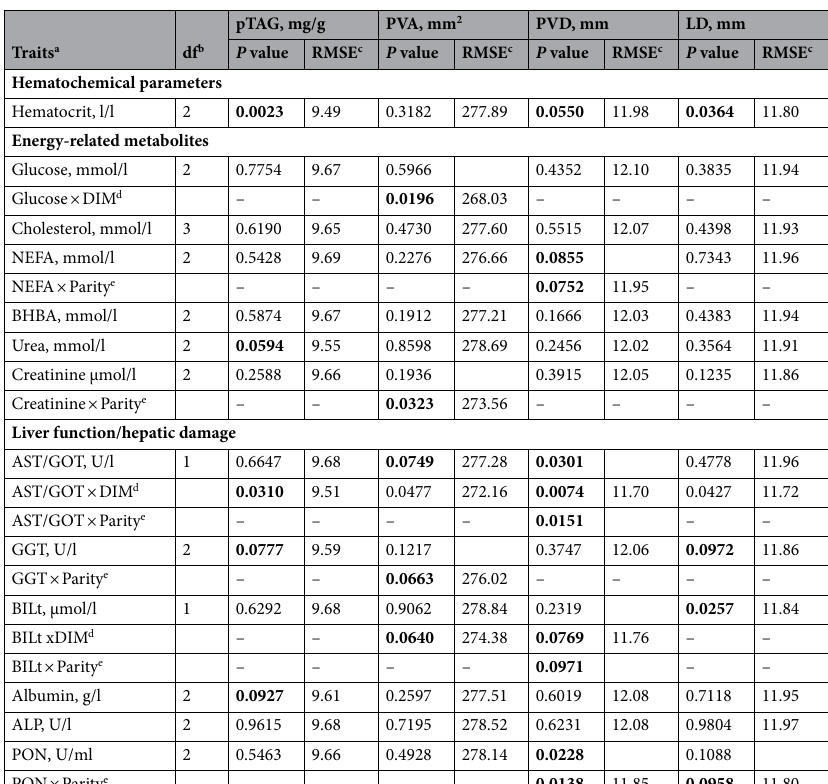
Table 2. Results from linear mixed model ( P values) for predicted liver triacylglycerol (pTAG), portal vein area (PVA), portal vein depth (PVD) and liver depth (LD). P values < 0.1 are highlighted using bold. a NEFA, non-esterified fatty acids; BHBA, β-Hydroxybutyric acid; AST, aspartate aminotransferase; GGT, γ-glutamyl transferase; BILt, total bilirubin; ALP, alkaline phosphatase; PON, paraoxonase. Linear models for pTAG, PVA, PVD and LD always considered the individual sources of variations, namely days in milk (DIM), parity and herd/date and, one at the time, all the hematic variables (in classes). Where P values were < 0.1, interactions between DIM and/or parity and hematic variables are reported. b df = the degrees of freedom depend on the number of classes in which hematochemical parameters have been discretized. c RMSE root mean square error. d DIM is constituted by 5 classes: class 1 ≤ 30; 30 < class 2 ≤ 60; 60 < class 3 ≤ 90; 90 < class 4 ≤ 120; class 5 > 120. e Parity is constituted by two classes: primiparous and